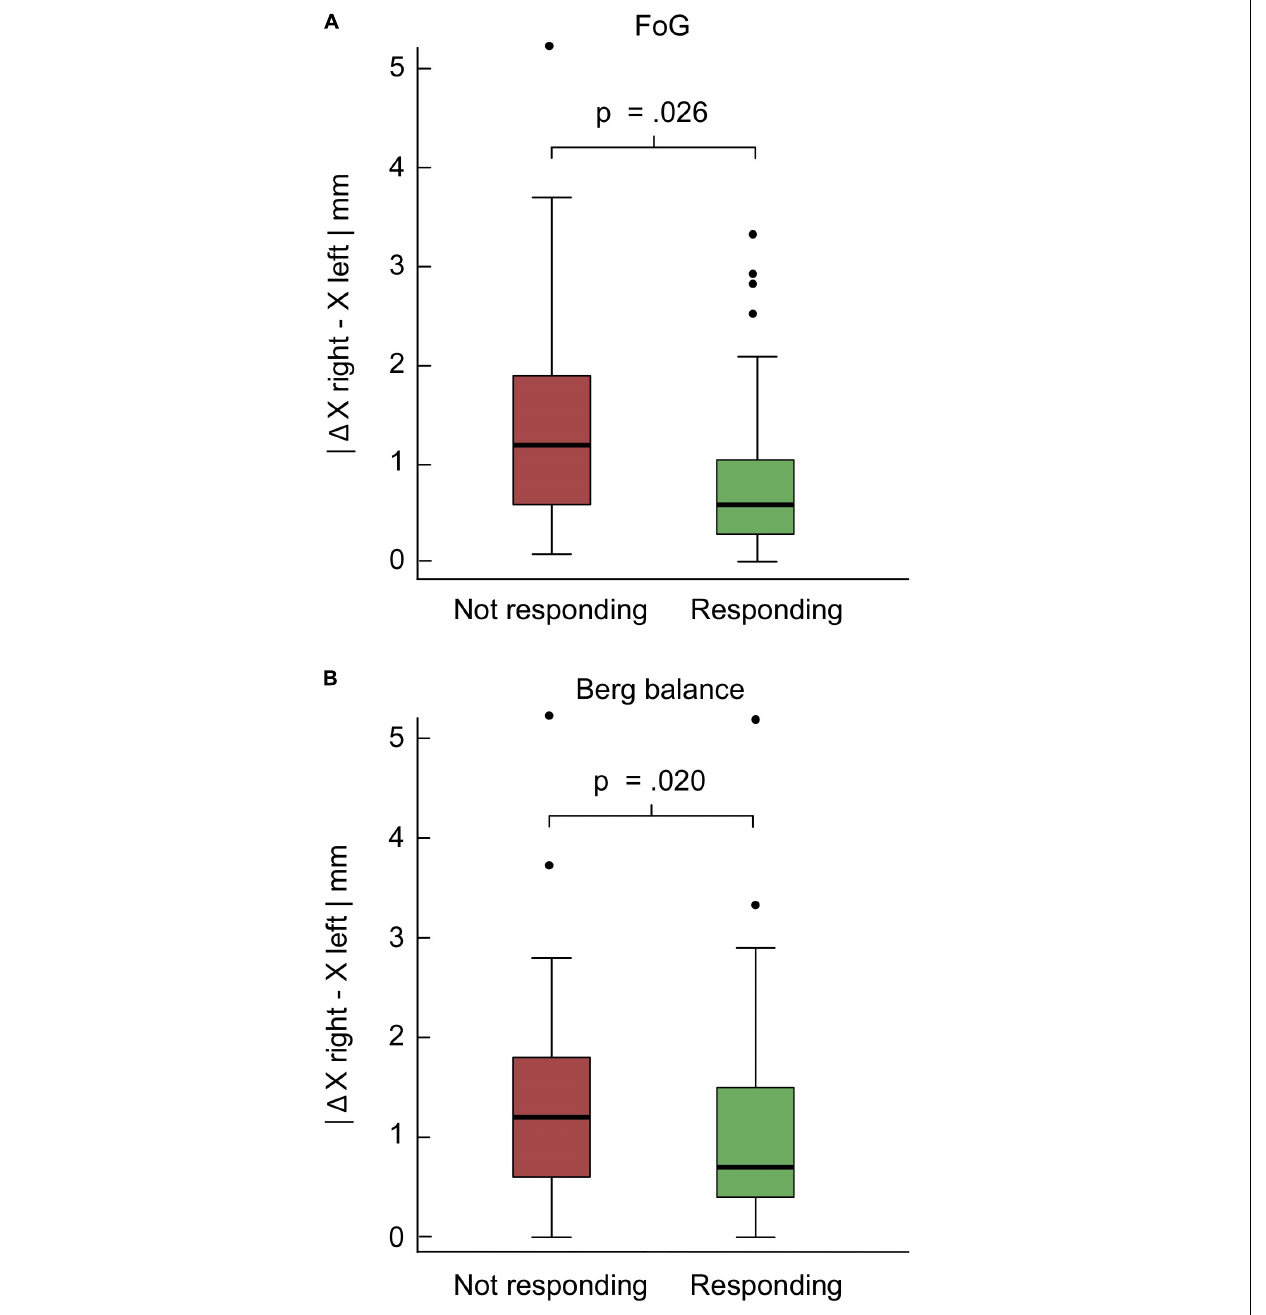
FIGURE 3 | Relation of post-operative freezing of gait (FoG) and balance outcome to deep brain stimulation (DBS) electrode reconstructed coordinates. Panels (A,B) show the box plots of the patients subdivided into two groups depending on the responsiveness to the subthalamic nucleus (STN)-DBS treatment. If the difference between the post-operative scores minus the pre-operative scores was negative in case of FoG and positive in case of the Berg balance, indicating a post-operative improvement of the scores, the patients were assigned to the responder group, otherwise to the non-responder group. P -values reported in panels (A,B) refer to the results of the general linear mixed